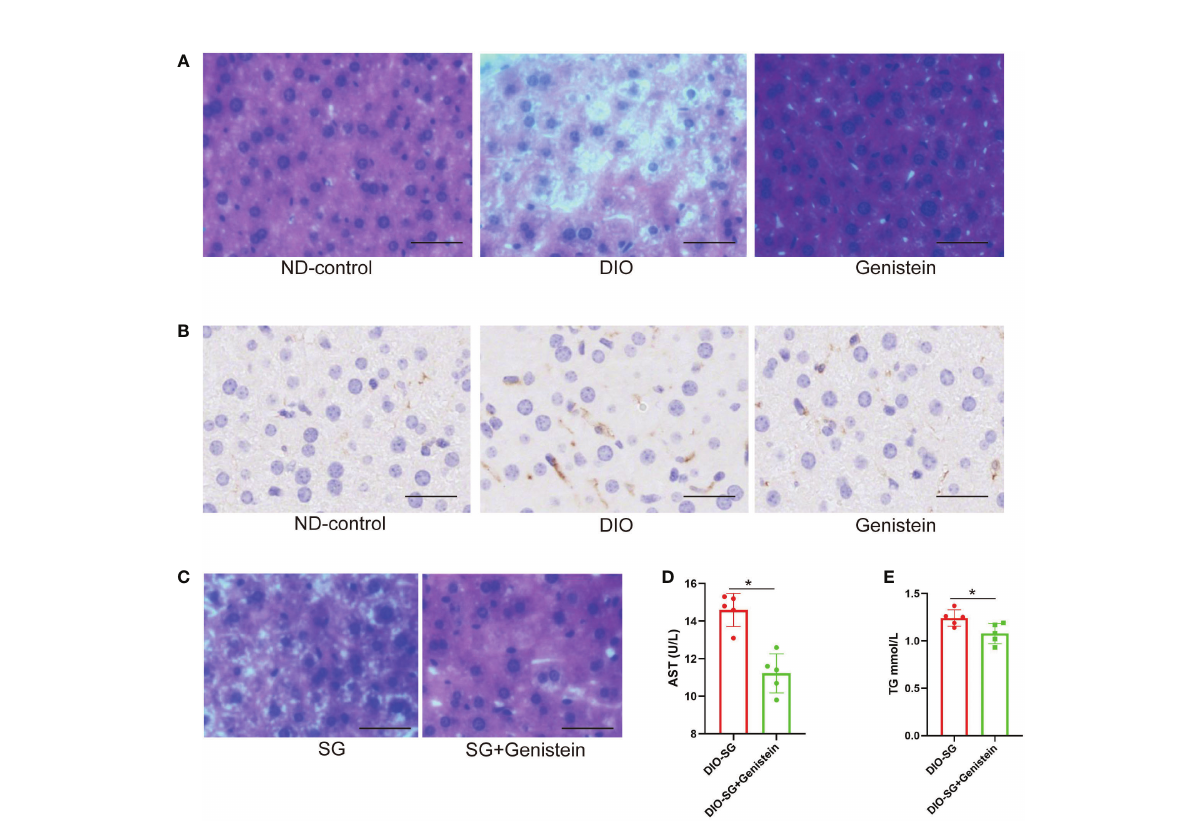
FIGURE 4 Genistein could relieve NAFLD and decrease the in fl ammation status in the liver. (A, B) The in fi ltration of macrophages (marked by F4/80) and lipid accumulation were detected by immunohistochemistry in the liver tissue of mice from different age-matched groups. ND-control: normal mice fed with a normal diet. DIO: diet-induced obese mice. DIO+GE: DIO mice fed with HFD containing 2% GE for 8 weeks. Scale bar = 50 m m. (C) . HE staining of livers from SG and SG+ GE mice. Scale bar = 50 m m (D, E) . Serum AST and TG concentrations in SG and SG + GE mice. The DIO mice received and were fed with HFD (the SG group) or HFD+0.2% GE (the SG+GE group) for 8 weeks. n = 5 in each group. Mann – Whitney U test was used to analyze the differences between the two groups. Data are presented as mean ± SEM, * p < 0.05. The P value in the image used in Figures 4E is equal to 0.0833, less than